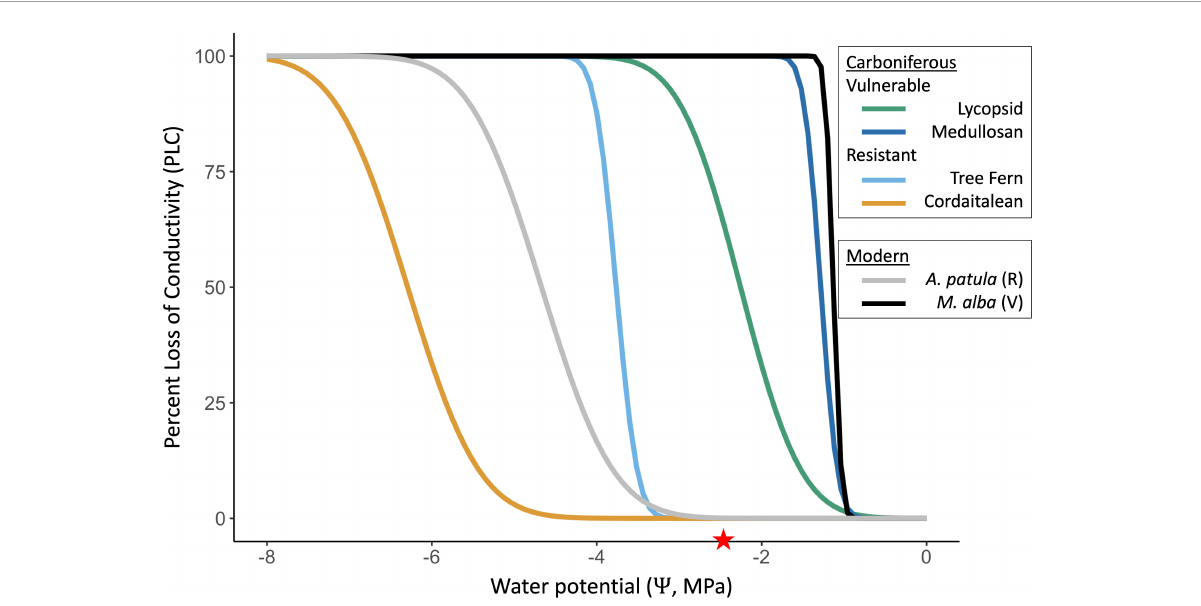
FIGURE4 Simulated vulnerability curves [i.e., percent loss of conductivity; PLC( (cid:57) )] for four extinct Carboniferous taxa and two extant taxa. Cavitation water potential ( ¯ (cid:57) c ) is estimated using an empirical relationship and based on novel anatomical measurements from xylem fossils for extinct plants, and using data from Hacke et al. (2006) for extant plants. These curves are cumulative distribution functions of normal distributions fit to ¯ (cid:57) c data. The medullosan vulnerability curve (dark blue) corresponds to the red line in Figure 2 . The red star on the horizontal axis is placed at the prescribed leaf wilting water potential (–2.5 MPa, White et al., 2020), as the displacement from the star of the PLC curve for a given taxon determines if simulated sapwood dysfunction will stop stomatal conductance before leaf